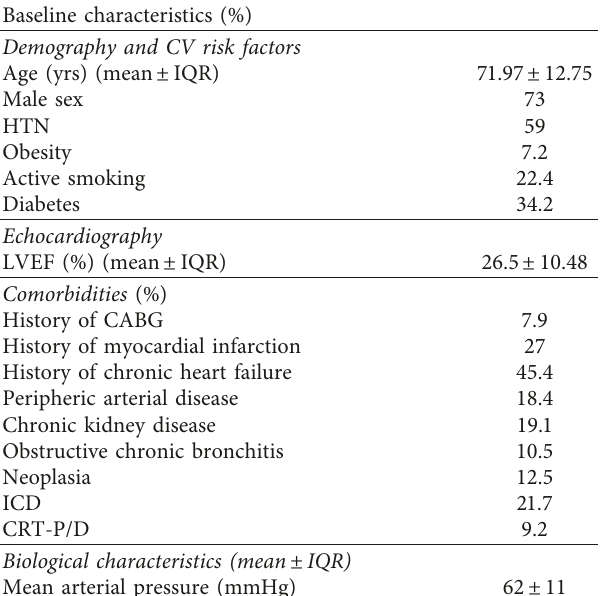
Table 1: Baseline